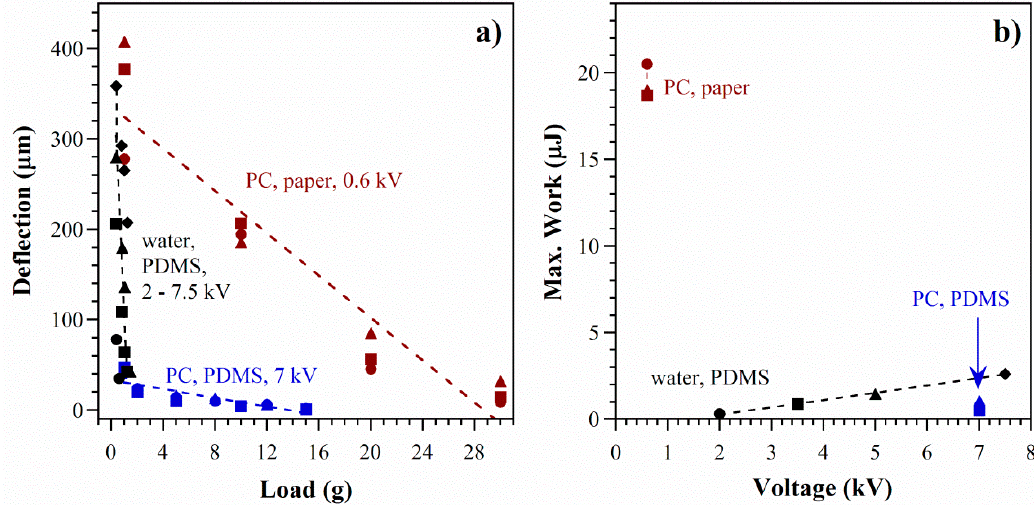
Figure 9. ( a ) Deflection as a function of load for the stacked configuration of this paper (same data as in Figure 7b; symbols have the same meaning) and for previously presented PDMS microchannel devices, filled with either PC (blue) or water (black); ( b ) Maximum work done by the paper-based actuator and the two PDMS devices.